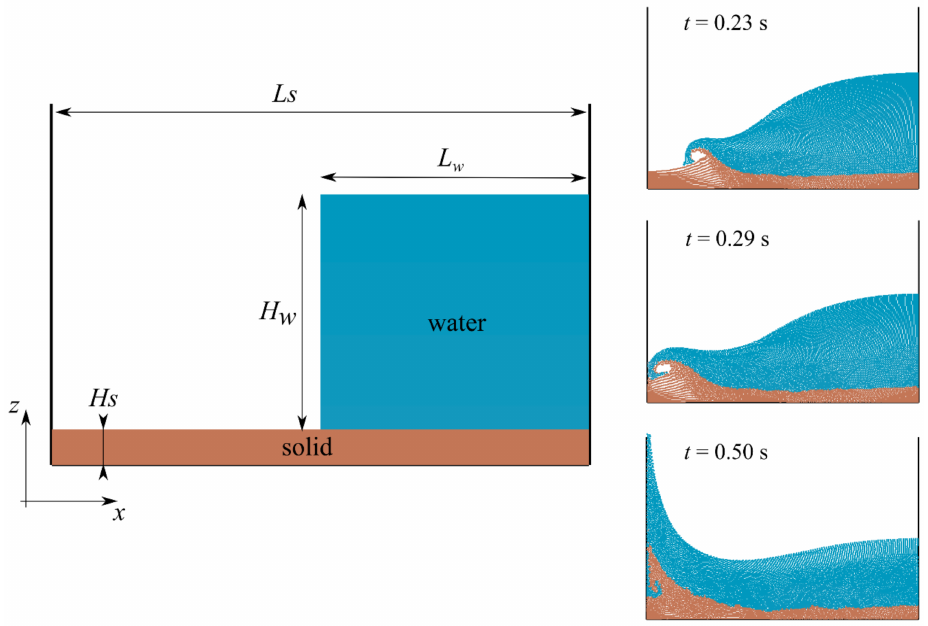
Figure 2. Computational domain of the 2D erosive dam break (initial time). Right-hand panels show the frames at some representative time instants (Ref. Run